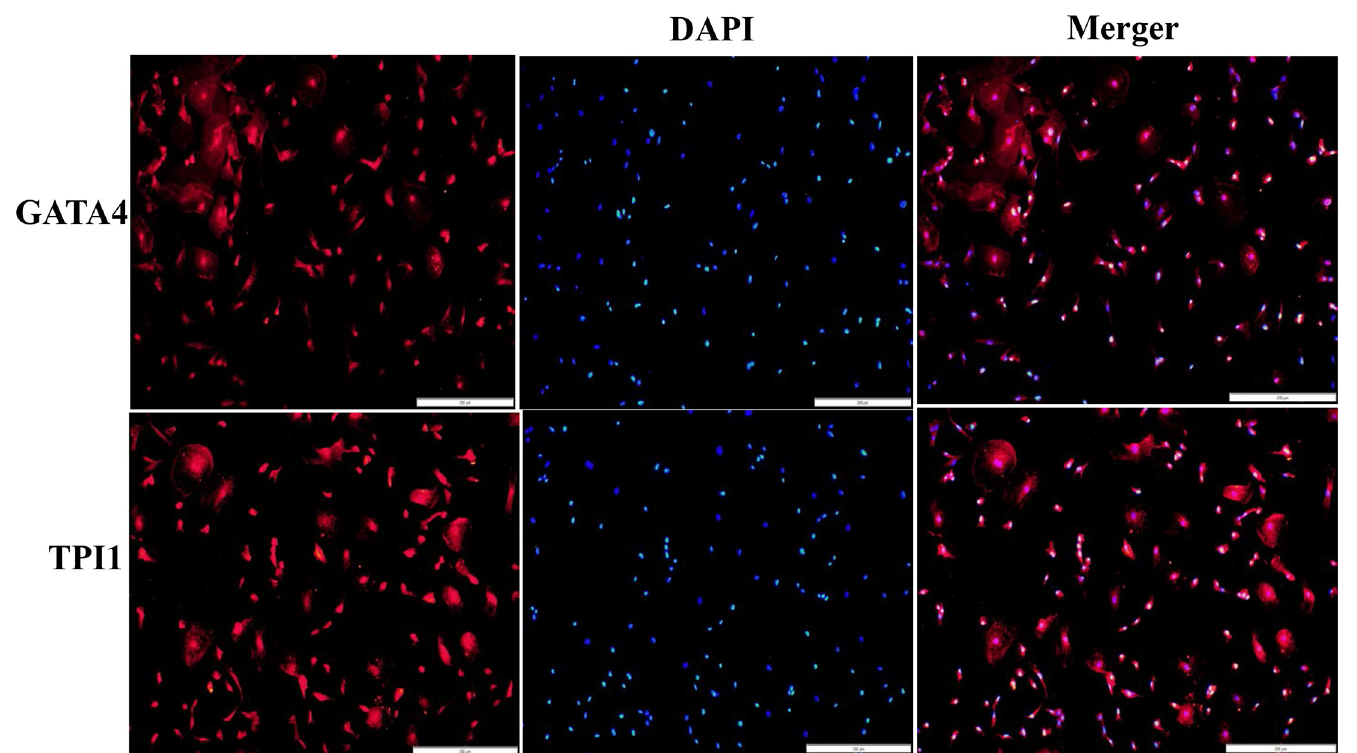
Fig 1. Immunofluorescence staining of primary SCs of Tibetan sheep (20 × ) [25].